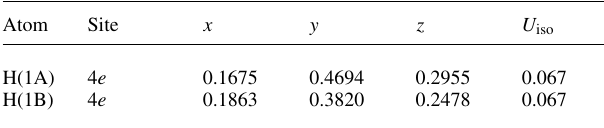
Table 2. Atomic coordinates and displacement parameters (in Å 2 )